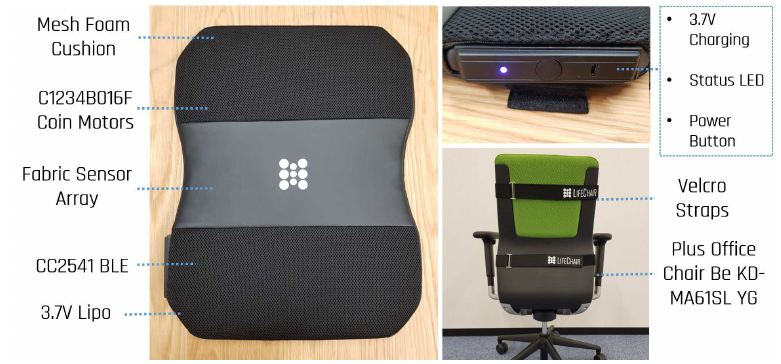
Figure 3. Overview of LifeChair components.